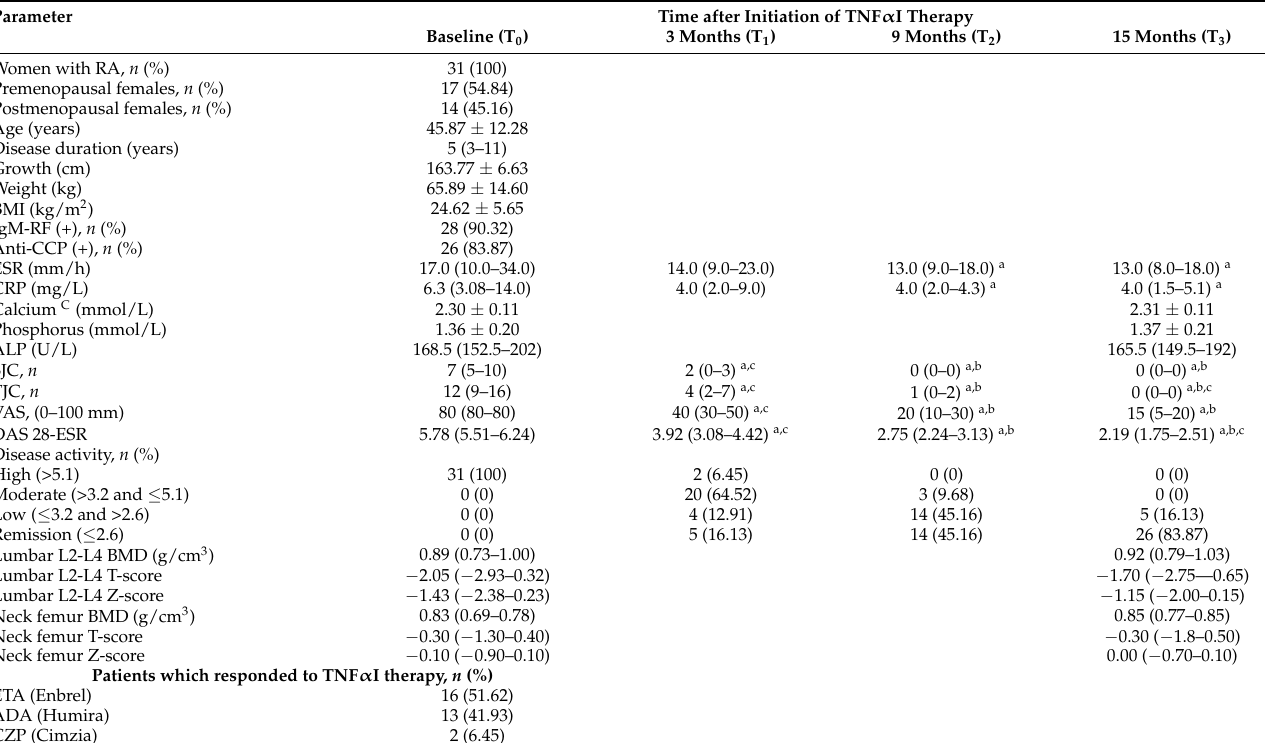
Table 3. The demographic, clinical, biochemical and functional variables during 15-month anti-TNF- α therapy in women with rheumatoid arthritis.